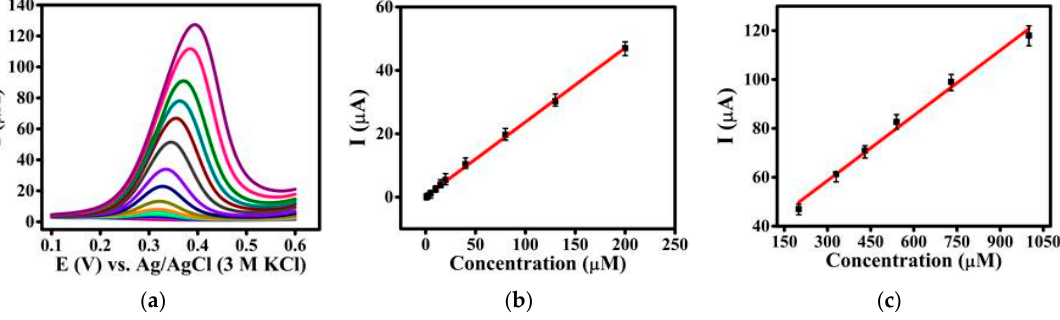
Figure 6. ( a ) DPV responses of Sp ‐ At/MWCNTs/CPE with successive additions of different concentrations of GA from 500 nM to 1 mM in 0.1 M phosphate buffer (pH 4) at a scan rate of 0.1 V · s − 1 , pulse amplitude of 0.1 V, and pulse time of 0.02 s; current–GA concentration calibration curve for ( b ) low and ( c ) high concentrations of GA.